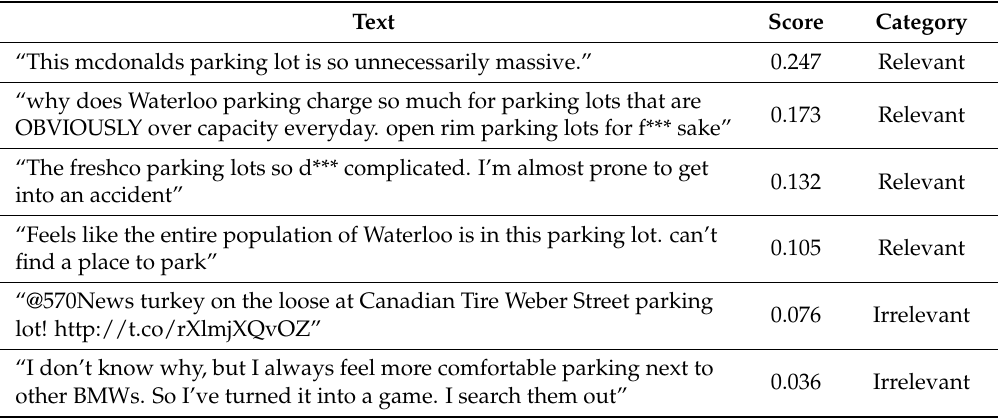
Table 1. Evaluating the relevance of a message to topic